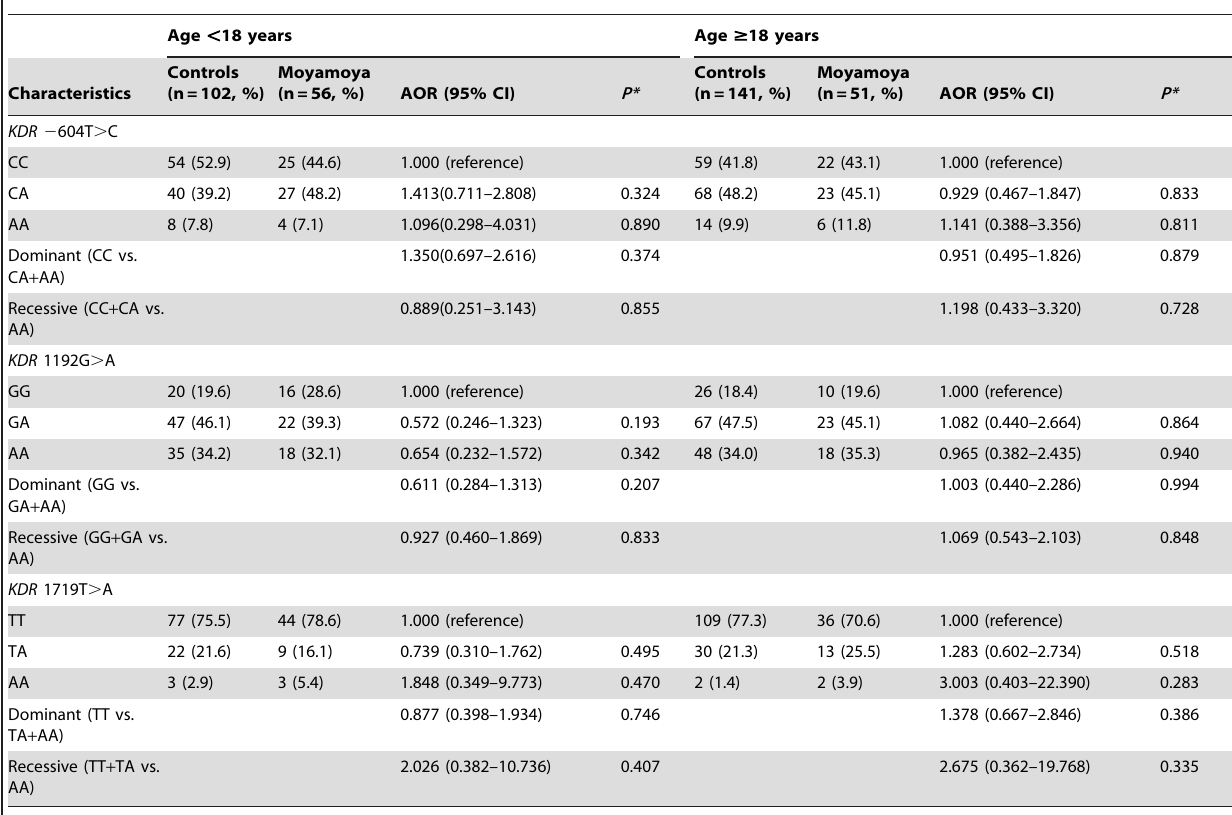
Table 5. The frequency of the KDR polymorphisms according to age.